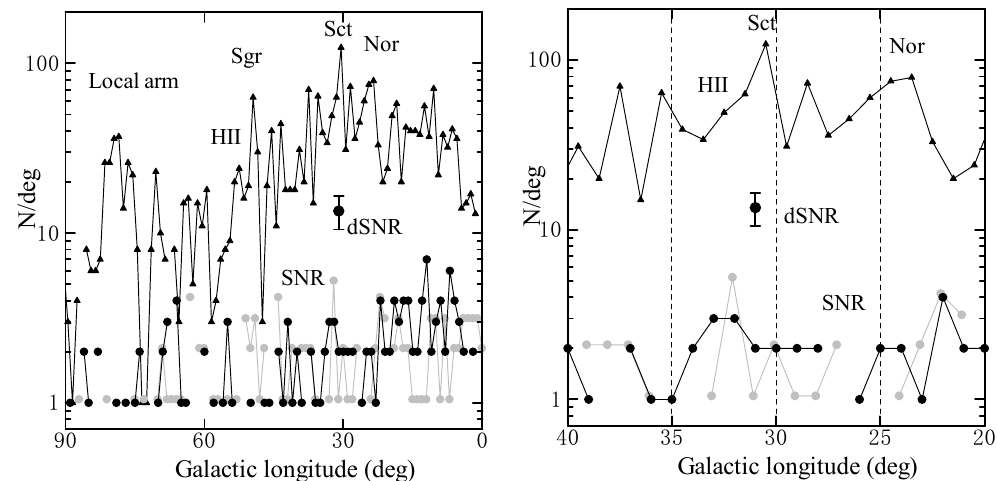
Figure 7. ( Left ) Longitudinal number density per one degree N of Green’s catalog SNRs (black and grey circles in the 1st and 4th Galactic quadrants, respectively), HII regions (triangles), and CO bubbles (dSNR) (big circle with error bars). ( right ) Same, but enlarged around the Scutum